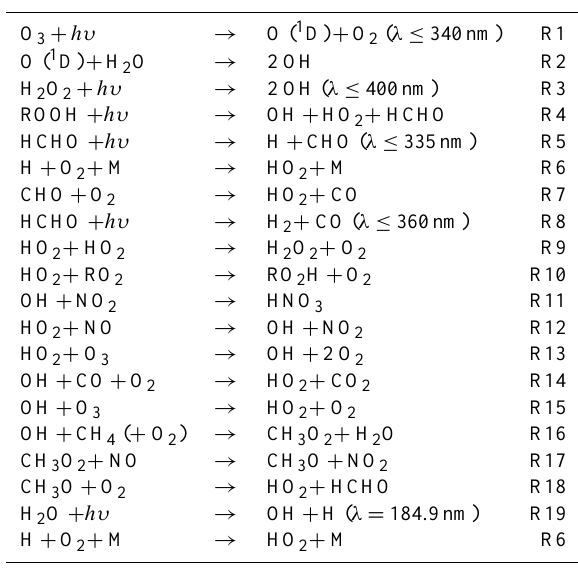
Fig. 2. HORUS detection axes are mounted in the wing pod below the wing ( © group graphic pool). Table 1. Atmospheric sources (R1–R8), sinks (R9–R11) and cy- cling (R12–R18) reactions of OH and HO 2 and calibration sources (R19 and R6) of HO x